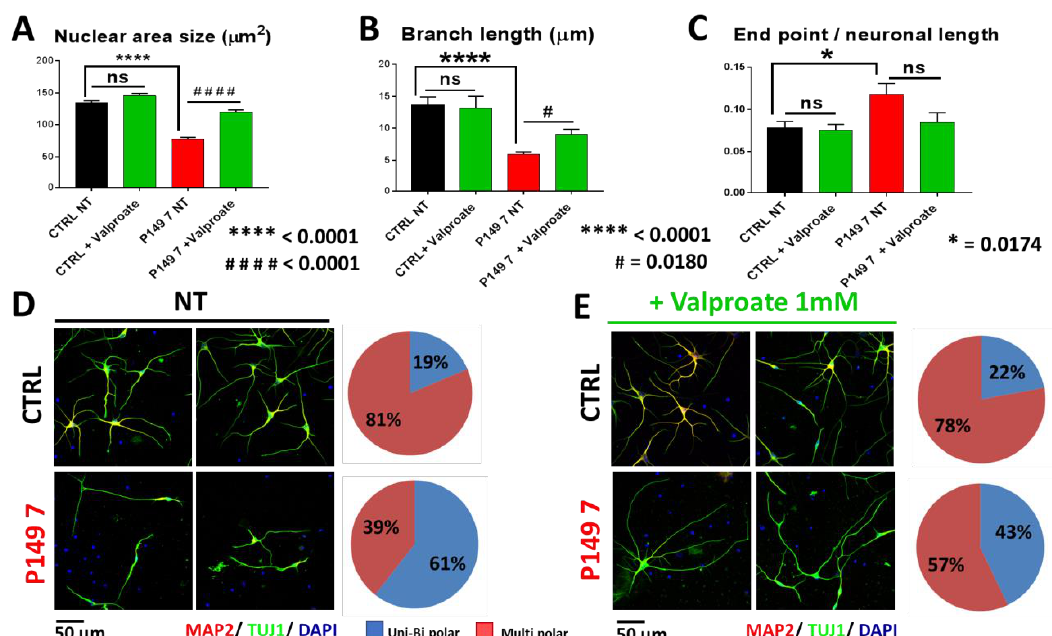
Figure 5. Valproate 1 mM effect on different morphological parameters of 45 days neurons from CTRL and P149 line 7 after 72 h treatment. The graphs quantify in patient’s neurons a highly significant decrease in ( A ) nuclear area size and in ( B ) branch length with respect to control (genotype effect: **** p < 0.0001) and a slight increase in ( C ) the ratio end point/neuronal length (* p = 0.0174). VPA treatment on P149 7 line significantly increases ( A ) the nuclear area size (#### p < 0.0001) and ( B ) the branch length (# p = 0.0180), while it does not yield a significantly correction of ( C ) the number of end points with respect to the neuronal length (ns = not significant) ( D , E ) amelioration of neuron layout with multipolar neurons increasing from 39% (NT) to 57% (VPA-treated). Immunofluorescence of MAP2 (red) and TUJ1 (green) markers, DAPI counterstaining. Scale bar 50 µm.